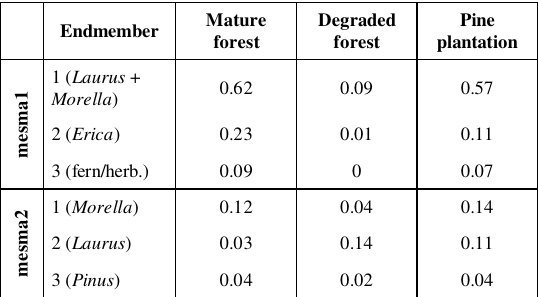
Table 3. Cover fractions derived from MESMA grouped by the three main vegetation covers in the study area: mature forest, degraded forest and pine